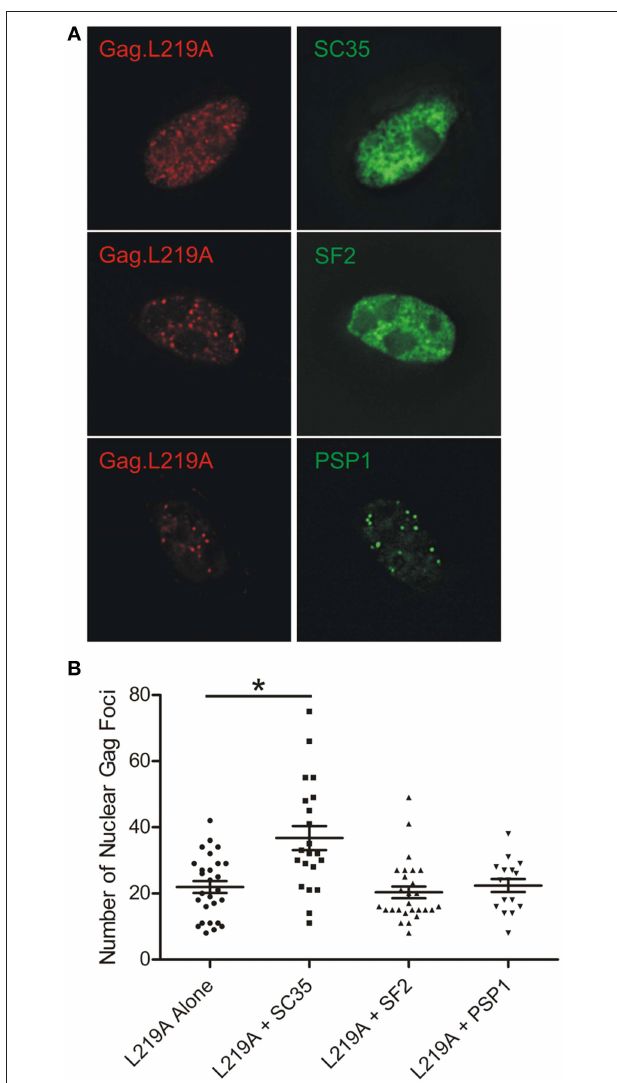
FIGURE 6 | Quantification of Gag.L219A nuclear foci number with co-expression of SC35, SF2, or PSP1. (A) Representative images of QT6 cells co-transfected with Gag.L219A and SC35, SF2, or PSP1. (B) Quantification of the number of Gag.L219A nuclear foci in QT6 cells expressing Gag.L219A alone or Gag.L219A co-transfected with SC35, SF2, or PSP1. Mean and standard error of the mean are indicated for each transfection. Nuclear foci in at least 16 QT6 nuclei were counted. * denotes p = 0 . 0003